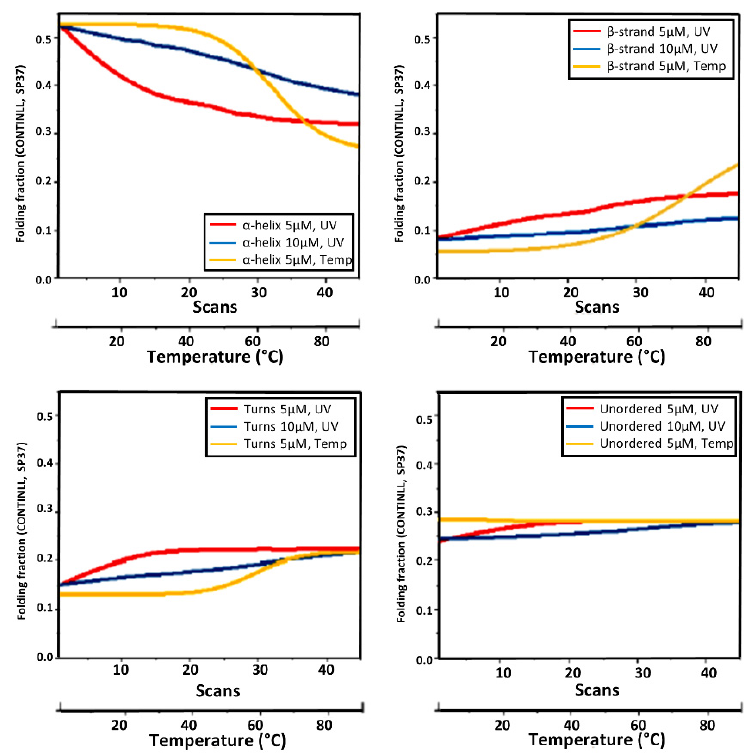
Figure 4. Fractions of elements of secondary structure: α -Helix (A), β -Strand (B), Turns (T) and Unordered (U) of HSAff as a function of UV (red for 5 µM and blue for 10 µM) and thermal denaturation (yellow for both concentrations) estimated from CD/SRCD spectra of Figure 3 using CONTINLL algorithm [17] with the SP37 data set from 37 soluble proteins.